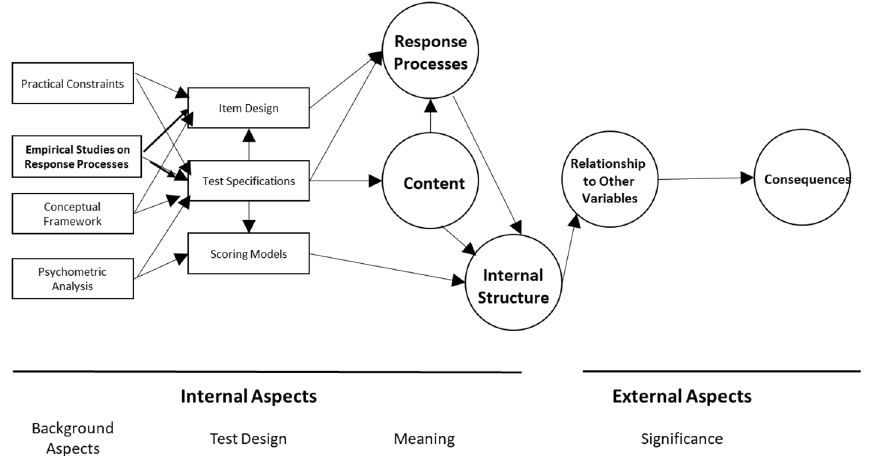
Fig. 1 An integrated model of construct